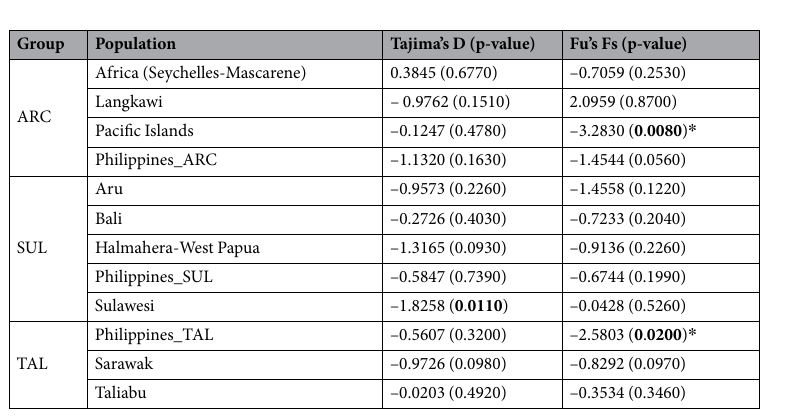
Table 2. Results of neutrality tests by population. Notes: Values in bold represent results where p < 0.05. Values marked with * represent Fu’s Fs results where p <